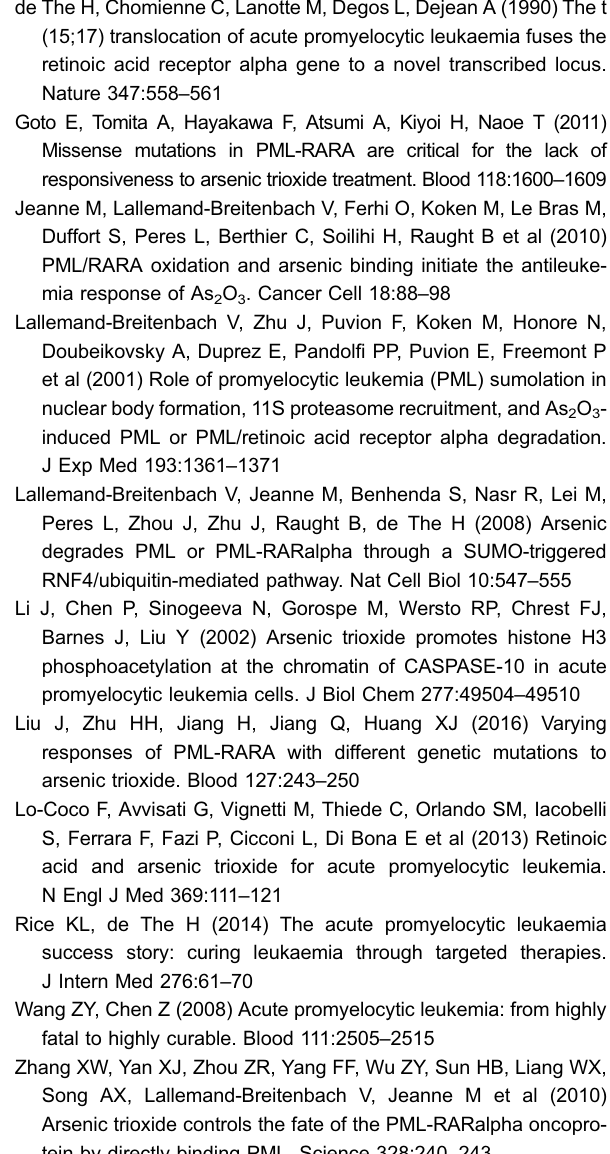
Figure 2. Ser214 is required for the SUMOylation of PML- RARA . (A) CHO cells were transfected with His-SUMO2 and PML-RARA or the mutants. At 36 h after transfection, cells were harvested and subjected to in vivo SUMOylation analysis. (B) 293Tcells were transfected with the indicated plasmids and then cells were incubated with or without with AS 2 O 3 for 4 h. (C) 293Tcells harboring the expression plasmids of PML-RARA mutants were treated with or without 2 µmol/L AS 2 O 3 for 4 h. Cells were harvested and lysed with RIPA buffer, and then the whole cell lysates were separated into soluble and insoluble fractions by centrifugation follow by immunoblotting. (D) The protein intensity of PML-RARA mutants in soluble (S) or insoluble (In) fraction was quanti fi ed. The ratio was expressed relatively to the sample without AS 2 O 3 treatment. (E) HeLa cells transfected with fl ag-tagged PML-RARA or mutants S214L and S220G were treated with or without 10 µmol/L AS 2 O 3 for 6 h. Anti-Flag antibody was used to detect the NB formation and the nuclear was stained with DAPI. Scale bar, 10 µm. (F) HeLa cells l transfected with S214L or A216T expressing plasmids were e treated with the drug (2 µmol/L, respectively) for 16 h. The abundance of S214L and A216T was detected by western blot with anti-Flag antibody. (G) On the basis of our and previous data, arsenic directly binds to the Cys212/213 and Ser214 amino acids in the PML B2 domain, leading to the formation of oligomerization and promote SUMOylation of PML, which followed by the ubiquitination and degradation of PML-RARA. Mutation of Ser214 totally disrupts the response of PML-RARA to AS 2 O 3 . A216T shows moderately defects in the response to AS 2 O 3 . L217F and S220G, mutations have no effect on the response of PML-RARA to AS 2 O 3 ..